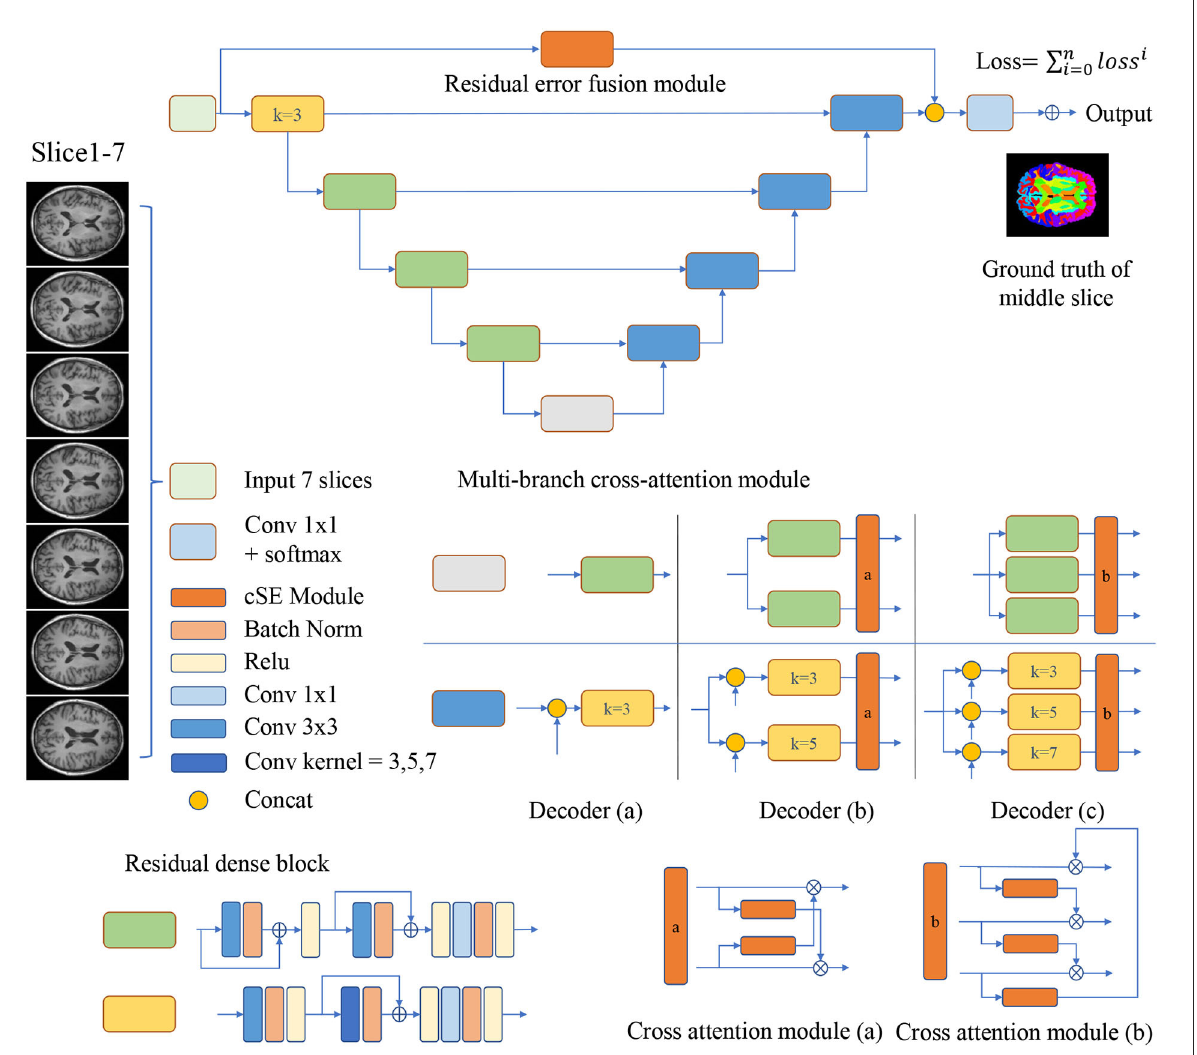
FIGURE1 Multi-branch Residual Fusion Network (MRF-Net) structure. Operations are shown in different colors, with detailed information on the right side. For the multi-branch cross-attention module, a detailed structure diagram is displayed and represented by the decoder (a–c) , where k represents the size of the convolution